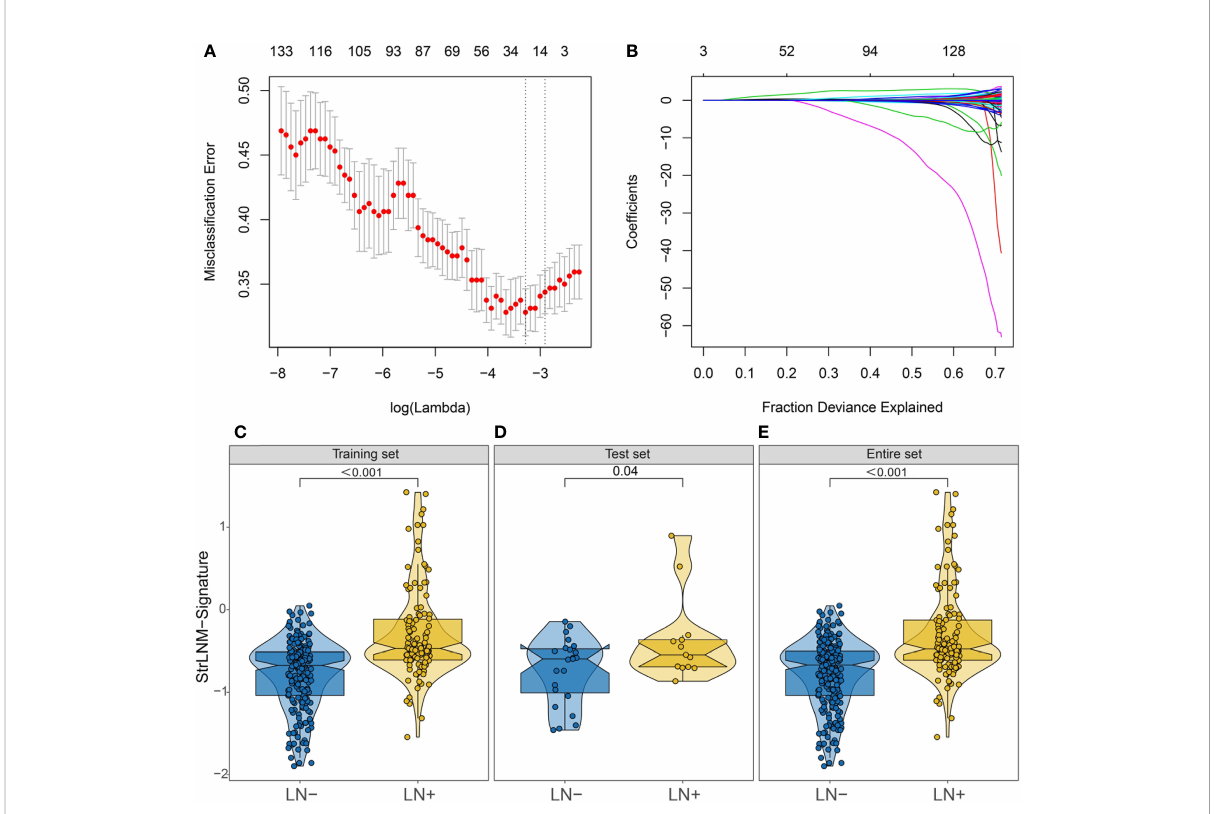
FIGURE 3 Feature selection using LASSO logistic regression model. (A) Tuning parameter ( l ) selection 10-fold cross-validation error curve. The misclassi fi cation error was plotted vs. log ( l ). The dotted vertical lines were drawn at the optimal values by the minimum criteria and the 1-SE criteria. (B) LASSO coef fi cient pro fi les of the 19 candidate EMT-related genes. A coef fi cient pro fi le plot was produced against the log ( l ) sequence. A vertical line was drawn at the value selected by 10-fold cross-validation, where the optimal l resulted in 17 nonzero coef fi